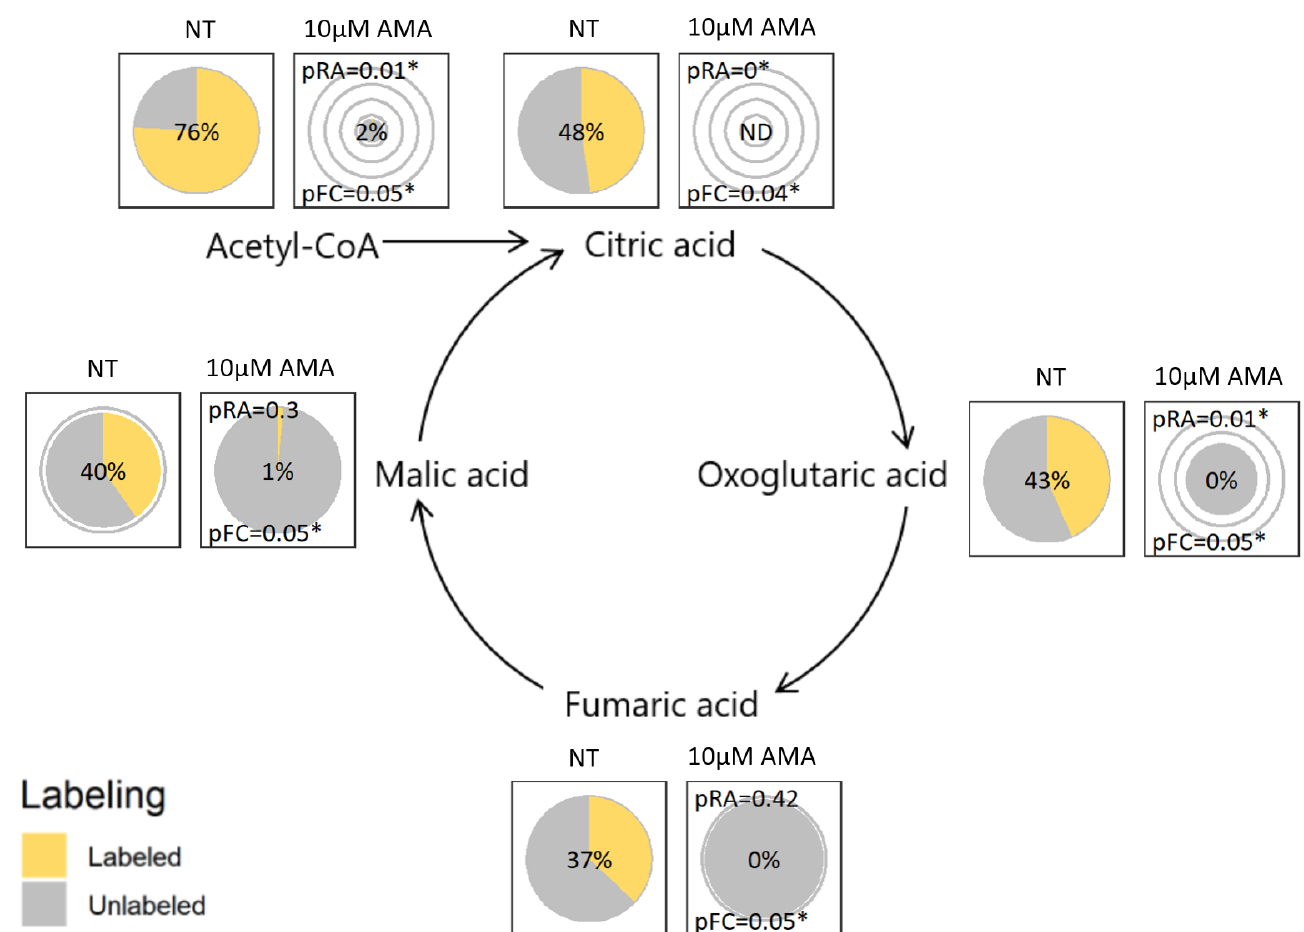
Figure 2. Visualizing tracer incorporation in the TCA cycle: Proposed pie chart visualization plotted on a metabolic map of the metabolization of Acetyl-CoA applied to two cohorts: non-treated (NT) or 10 µM antimycin A treated (AMA). Pie diameter shows the relative abundance of this compound, while the size of the yellow slice of the pie relative to the total size and the label in the center show the fractional contribution. pRA and pFC indicate the significance of the difference in, respectively, the relative abundance or fractional contribution with the NT cohort. * indicates a p value ≤ 0.05. The details of the visualization are explained in more detail in the Methods section. ND: not detected in any sample of this cohort.